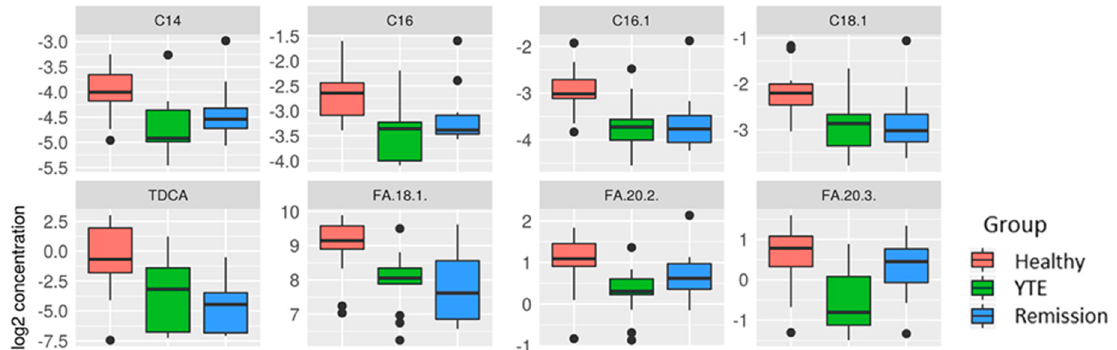
Figure 2. Box plots comparing metabolites after log-2 transformation in healthy controls, dogs with YTE, and dogs with YTE in clinical remission. Boxplots of metabolites with significant differences between healthy dogs and YTE dogs are shown. Box plots represent the 25–75th percentile; the median is shown as the heavy dark horizontal line, and vertical lines extend to the minimum and maximum values. Dots represent outliers. Legend: C14, tetradecanoylcarnitine; C16, hexadecanoylcarnitine; C16:1, hexadecenoylcarnitine; C18:1, octadecenoylcarnitine; TDCA, taurodeoxycholic